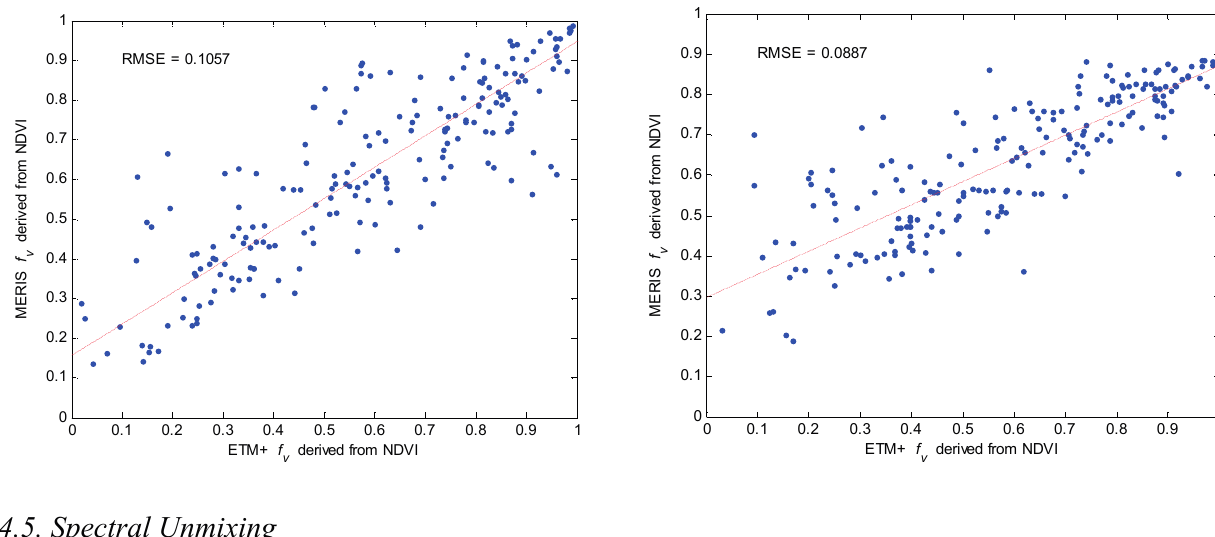
Figure 9. Correlation between f from ETM+ NDVI, for image pair 1 ( left ), and image pair 2 ( right